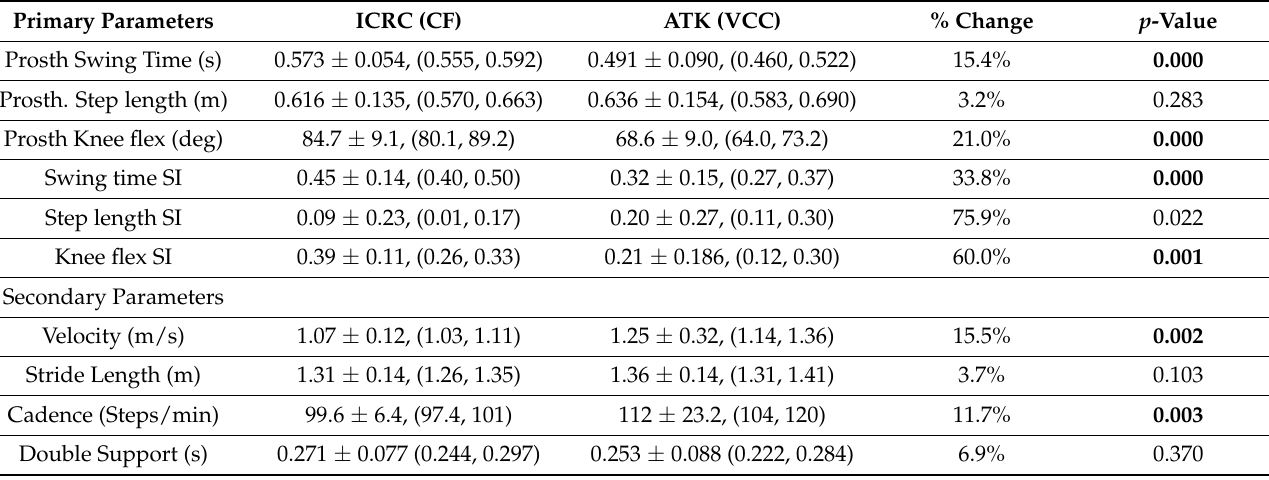
Table 3. Gait parameters for ICRC and ATK for fast walking speeds.